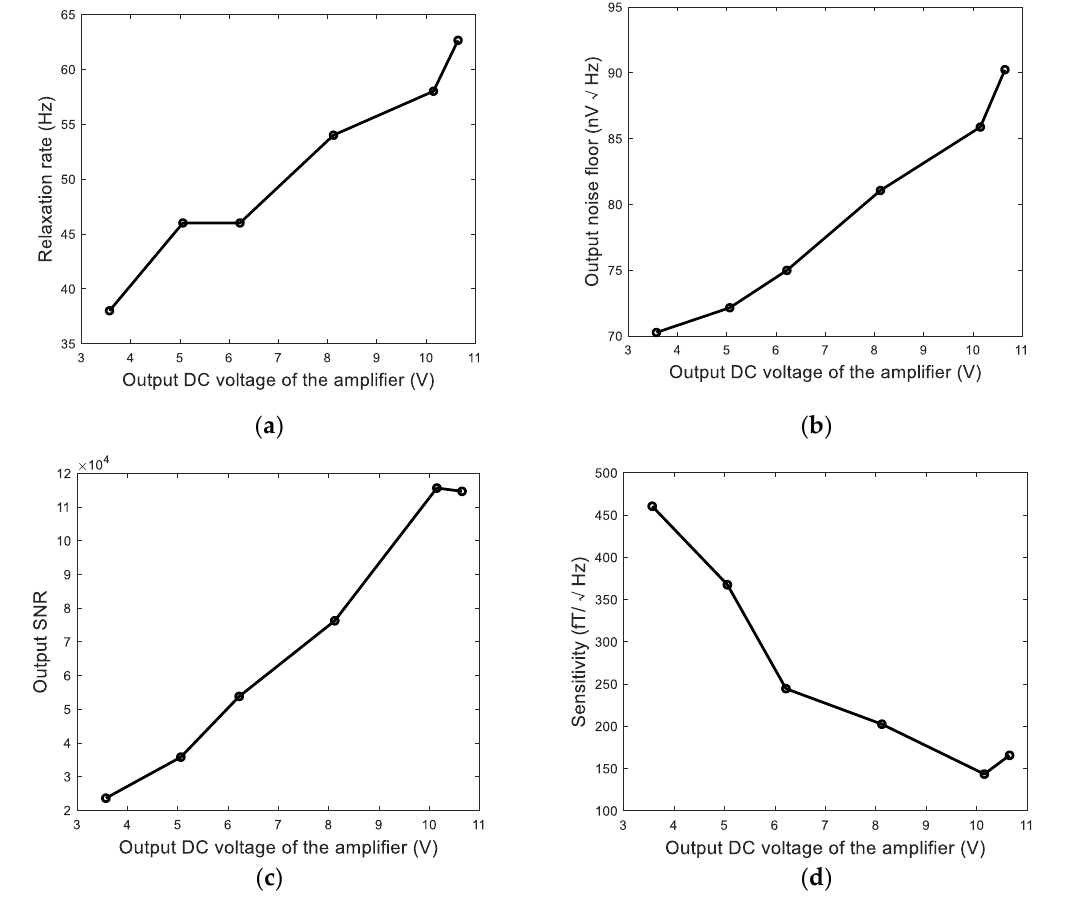
Figure 12. ( a ) Result of the relaxation rate changing as a function of the output DC voltage of the amplifier. ( b ) Result of the output noise floor changing as a function of the output DC voltage of the amplifier. ( c ) Result of the output SNR changing as a function of the output DC voltage of the amplifier. ( d ) Result of the sensitivity changing as a function of the output DC voltage of the amplifier.